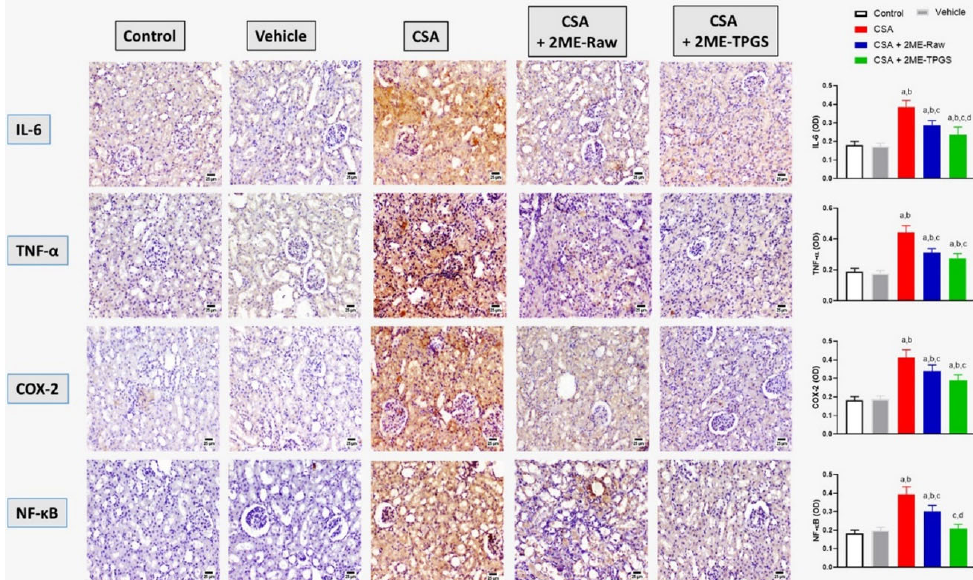
Figure 5. Effect of 2ME ‐ TPGS on IL ‐ 6, TNF ‐α , COX ‐ 2 and NF κ B expression as determined immuno ‐ histochemically in kidney tissues of rats challenged with cyclosporine (CSA). Bar charts are mean ± SD ( n = 6). a: Significantly different from respective Control at p < 0.05; b: significantly different from Vehicle at p < 0.05; c: significantly different from CSA at p < 0.05; d: significantly different from CSA + 2ME ‐ Raw at p < 0.05.